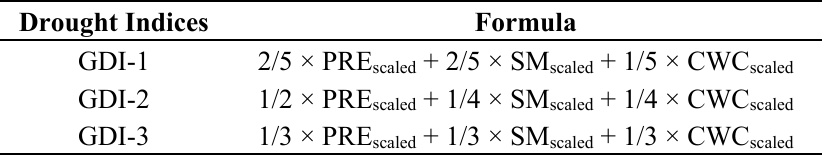
Table 1. The different GDIs combined with different weights for the scaled precipitation, SM and CWC